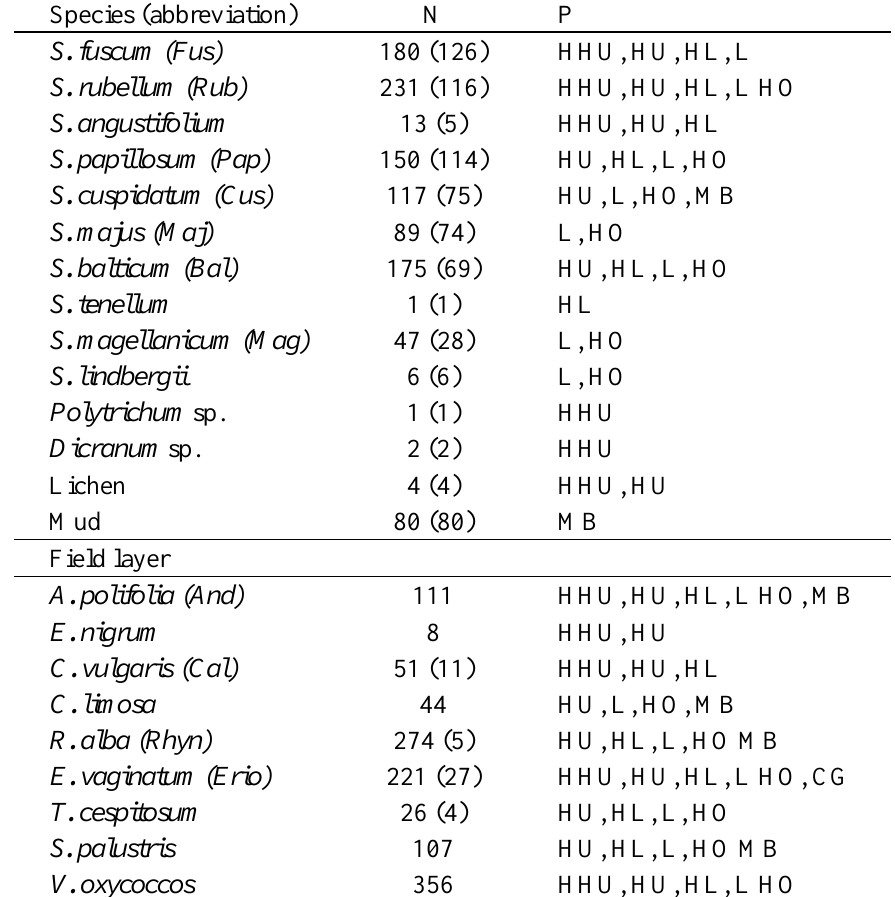
Table 2. Moss and field layer species occurring in the samples of 2014. N is the number of plots on which the species occurred (was dominant). P shows the microforms where the species was present.